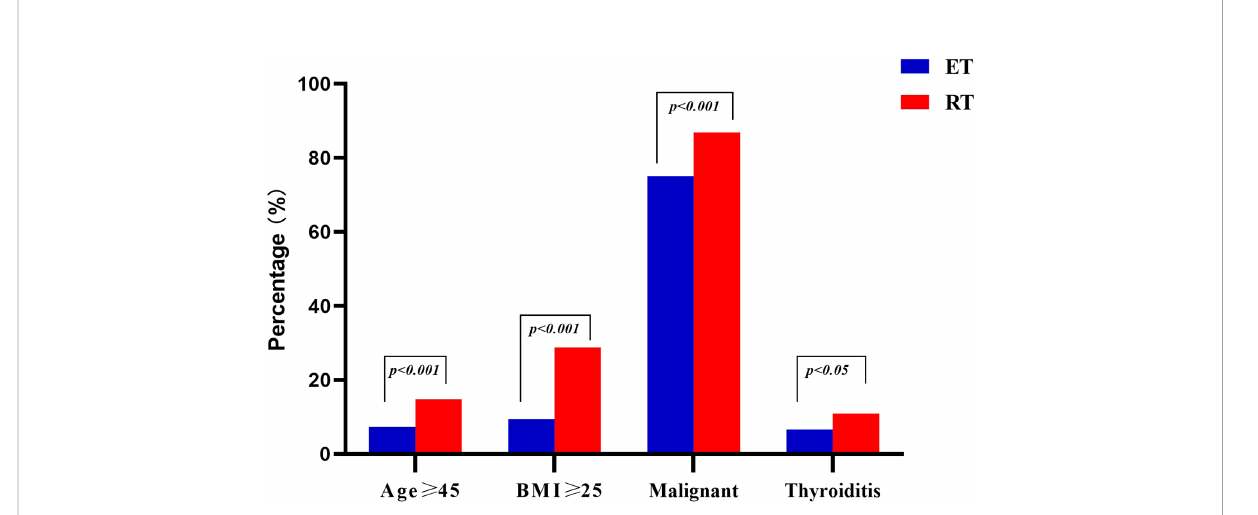
FIGURE 3 Comparison of demographics and pathological characteristics between ET and